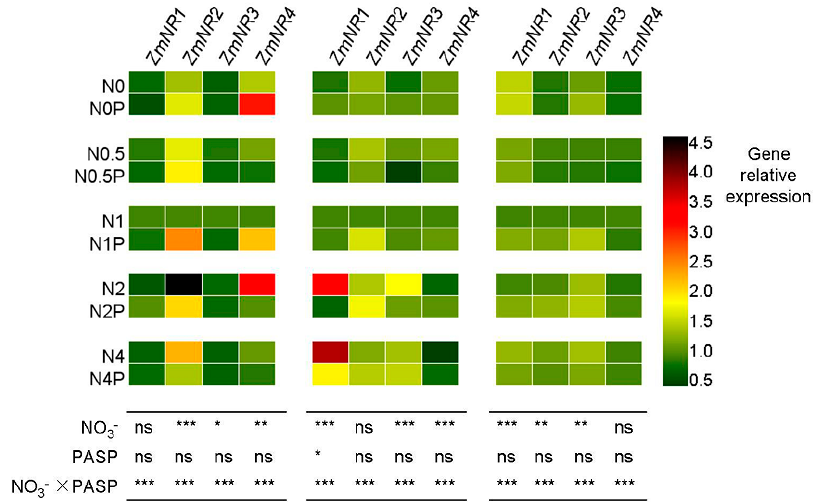
Figure 6. Relative expression of ZmNR1 , ZmNR2 , ZmNR3 , and ZmNR4 in the roots on the 1st, 3rd, and 7th day after PASP treatment. Data were presented as the mean of 15 plants in each treatment. ns, *, **, and ***, Statistically significant differences according to multiple analyses at p > 0.05, p < 0.05, p < 0.01, and p < 0.001. N0, N0.5, N1, N2, and N4 indicate the seedlings treated with 0, 0.5, 1.0, 2.0, and 4.0 mmol L − 1 of NO 3 − without PASP treatment, respectively. N0P, N0.5P, N1P, N2P, and N4P indicate the seedlings treated with 0,